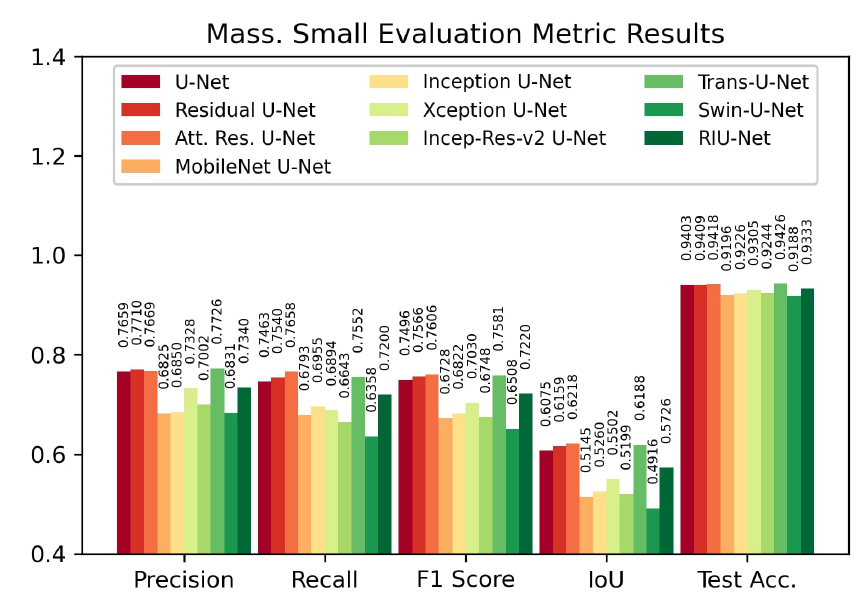
Figure 8. Evaluation metric results on Massachusetts Small test set.